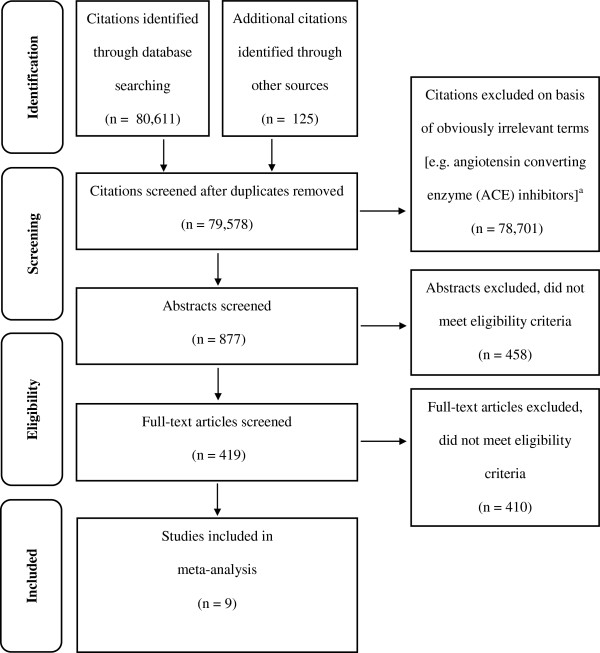
PRISMA Flow Diagram [35].